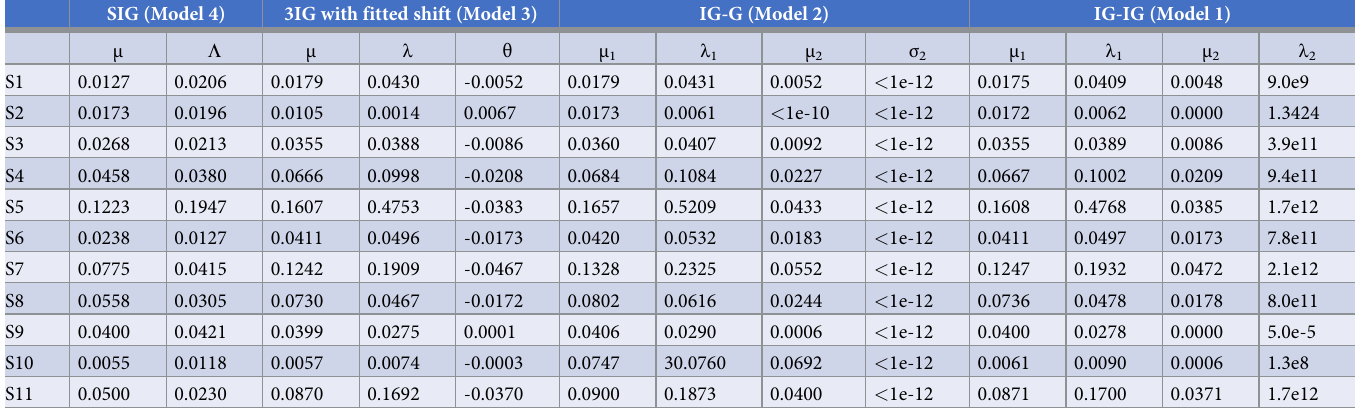
Table 4. Fitted parameter values for Models 1–4 for awake and at rest